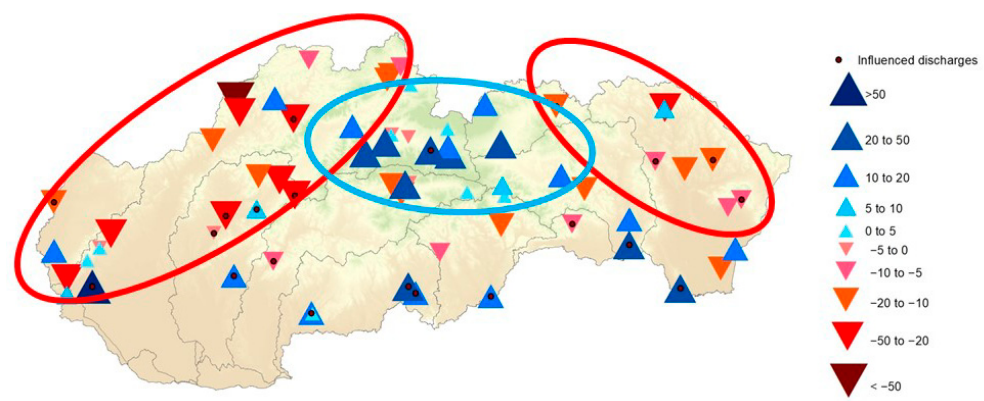
Figure 14. Areas of prevailing increases (blue) and decreases (red) of Q 355d from 2001–2015 compared to